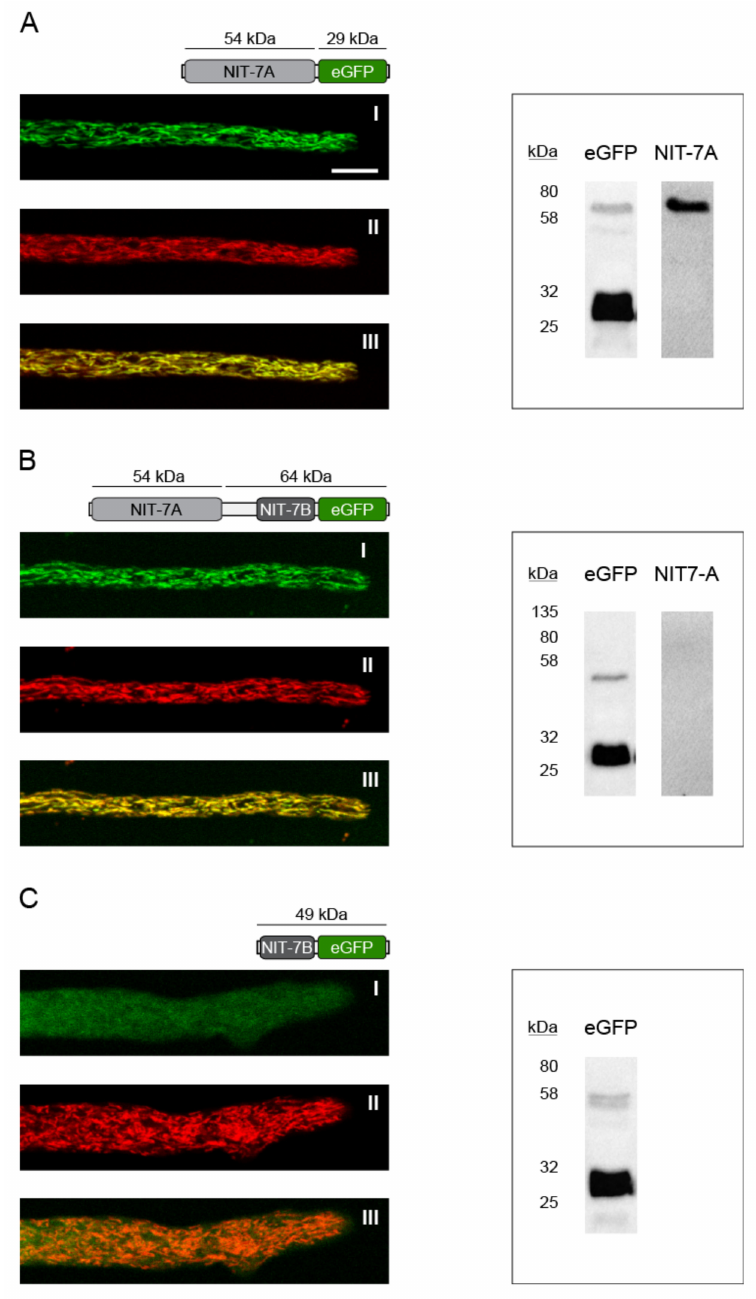
(Table 1). NIT-7A- and NIT-7AB-eGFP fusions localized to the mitochondria (Figure 7A,B), while in contrast, NIT-7B did not (Figure